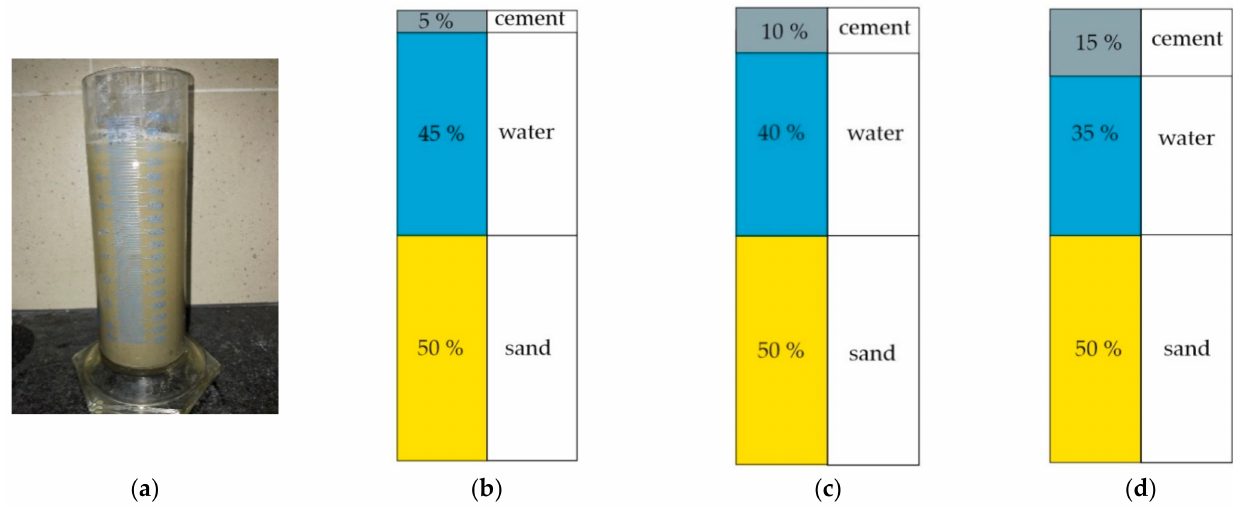
Figure 1. The proportion of the components of the backfill mixture: ( a ) general view of measuring cylinder; ( b ) 5% cement; ( c ) 10% cement; ( d ) 15% cement.